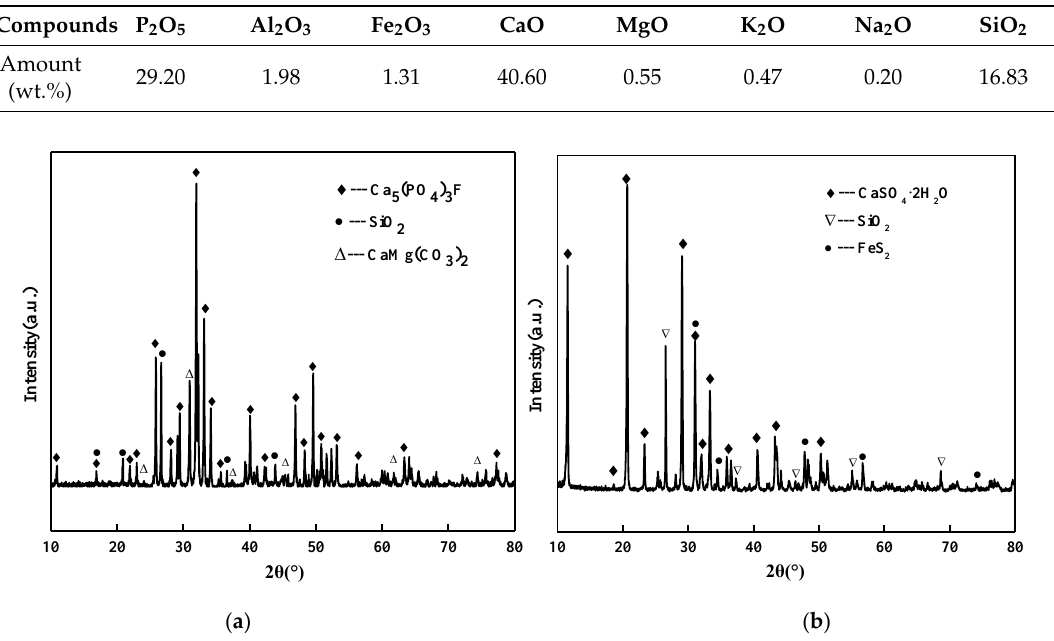
Table 1. composition of phosphate rock.